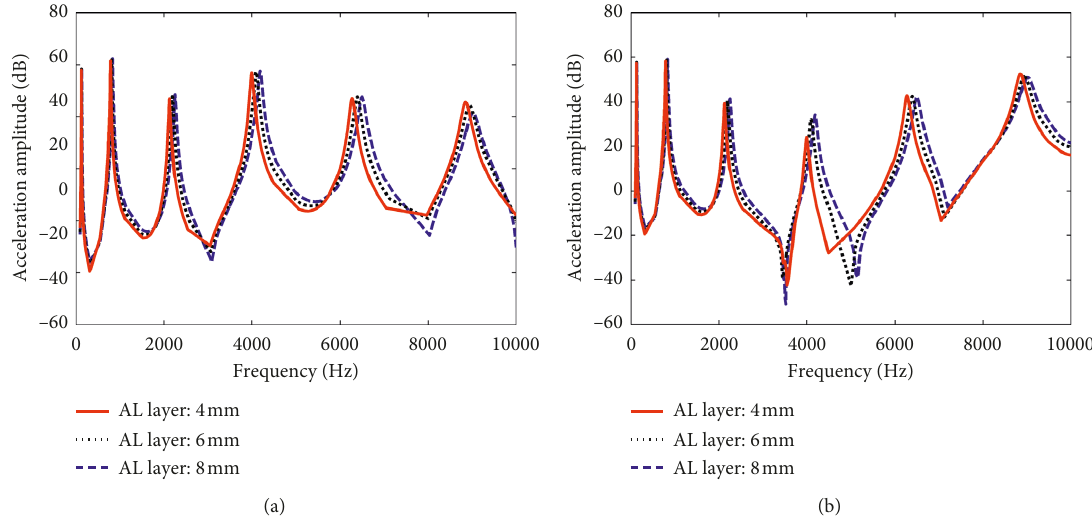
Figure 13: Effect of the aluminum layer thickness on acceleration responses: (a) ABH region ( x ( x m � 10 . 87 cm).